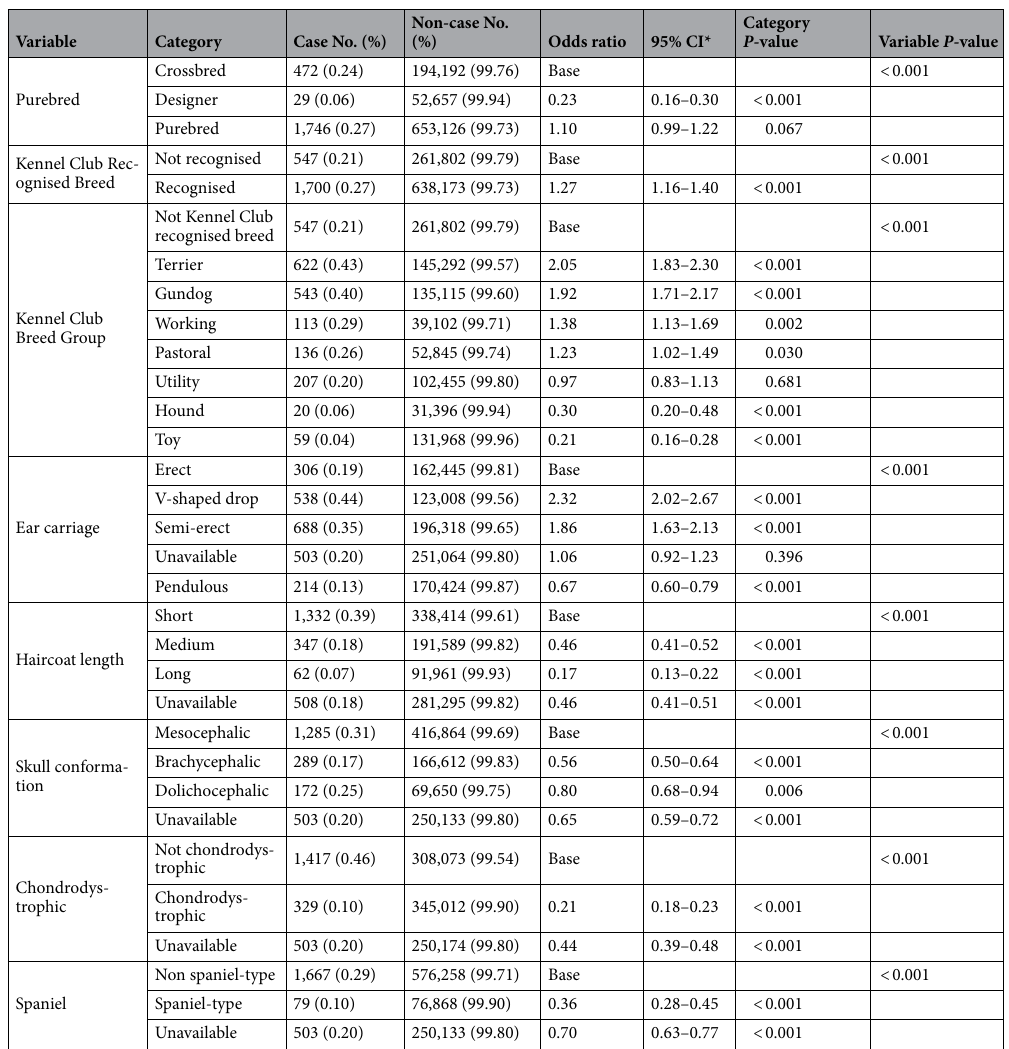
Table 2. Descriptive and univariable logistic regression results for breed-derived risk factors for aural haematoma during 2016 in dogs under primary veterinary care in the VetCompass™ Programme in the UK. Column percentages shown in brackets. *CI confidence